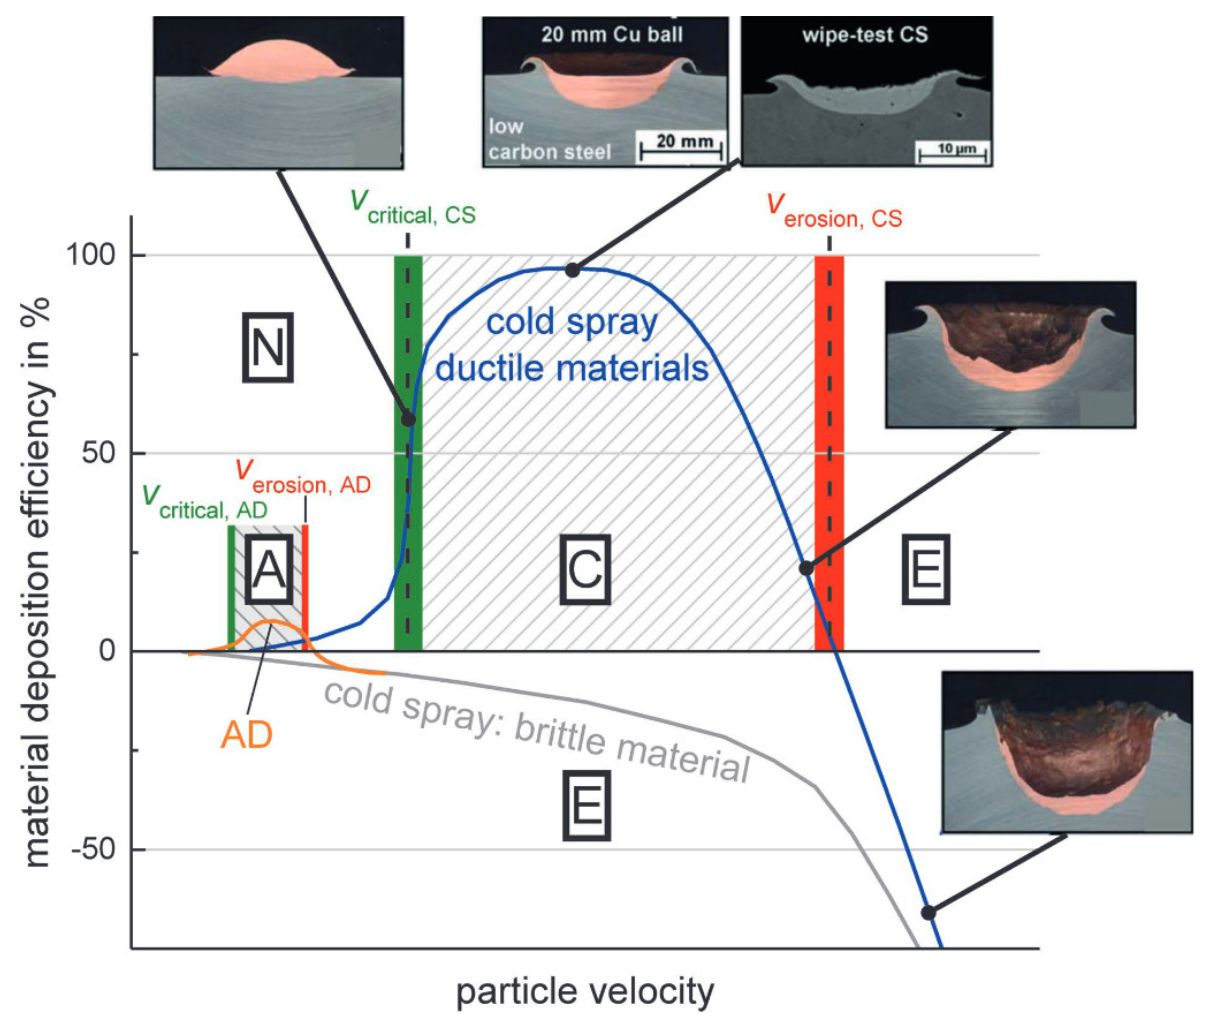
Figure 4. “Deposition Window” for ductile (CS) and brittle (AD) materials as a DE vs particles velocity function. Areas: A—AD deposition window, C—CS deposition window, E—substrate erosion (too high particles velocity) or ceramics application in CS, N—no deposition [73].